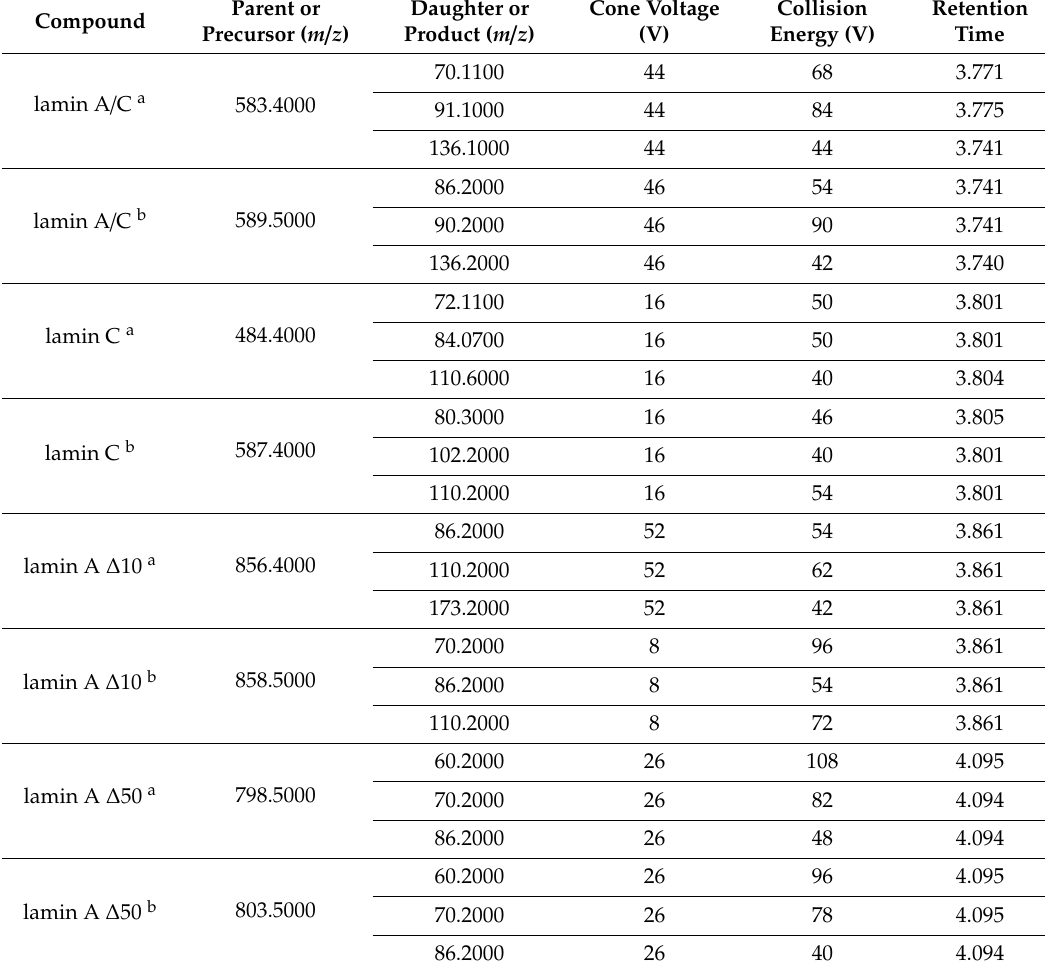
Table 2. Optimized lamin transitions for all four di ff erent peptides, with ion mode (ES + ). Parent Compound